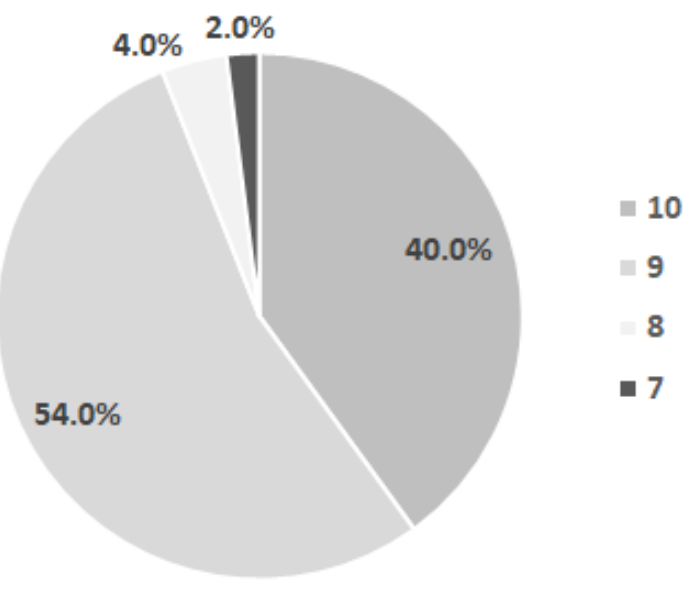
Figure 3. Distribution of children by the Apgar score.